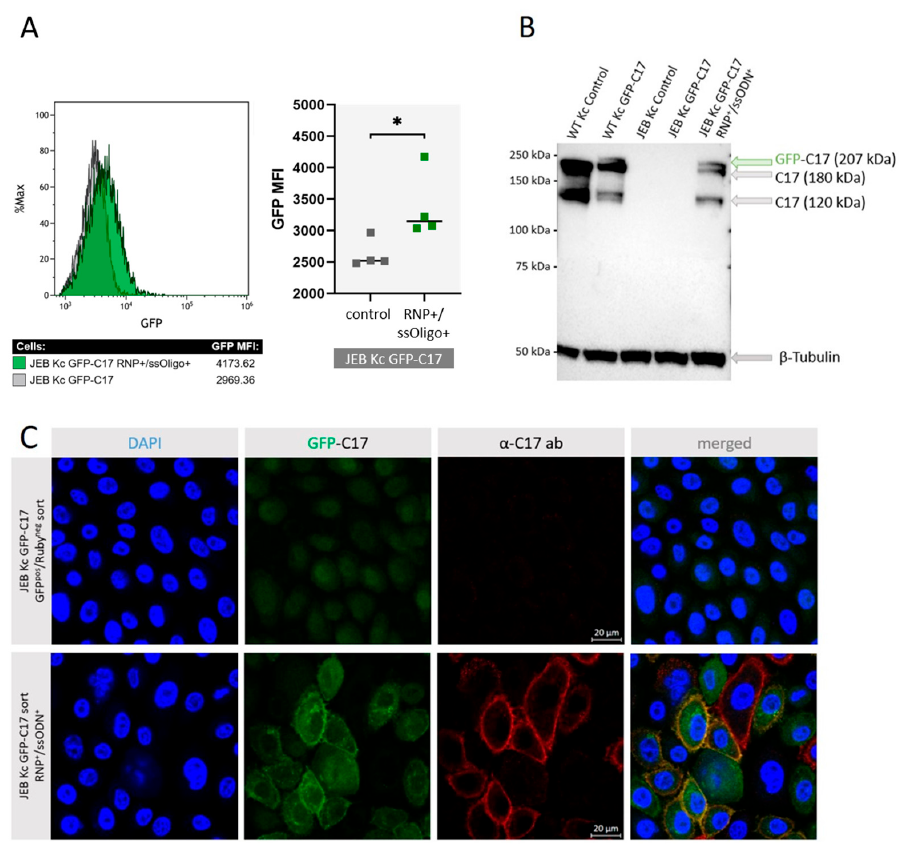
Figure 5. CRISPR/Cas9-mediated GFP-C17 restoration in JEB keratinocytes. ( A ) As a result of the RNP/ssODN-treatment of GFP-C17 mut -expressing JEB cells flow cytometric analysis showed a significant (*) increase of the median GFP signal intensity in treated cells upon gene repair in four individual experiments. Statistical analyses (paired Student’s t-test) were performed using GraphPad Prism 9. ( B ) Western blot analysis of cell lysates from RNP/ssODN-treated GFP-C17 mut -expressing JEB cells showed restored full-length C17 (180 kDa), full-length GFP-C17 (~207 kDa) as well as the presence of the C17 ectodomain at 120 kDa. ( C ) Immunofluorescence microscopy showed no fluorescence in untreated JEB GFP-C17 mut -expressing JEB cells, whereas RNP/ssODN treatment led to the accurate restoration and integration of full-length GFP-C17 within the plasma membrane of edited cells. The cell’s nuclei were stained with 4’, 6-Diamidino-2-phenylindol (DAPI, blue). 2.4. GFP-C17 Protein Is Deposited at the Correct Location within Organotypic 3D Cultures To further verify the correct localization of restored GFP-C17, immortalized WT fibroblasts and either WT Kc, untreated or RNP/ssODN-treated GFP-C17 mut -expressing JEB Kc were used to generate full-thickness skin equivalents (SE). Haematoxylin and Eosin (H&E) staining confirmed the correct formation of the skin layers revealing a normal epidermal stratification (Figure 6A). In SEs derived from untreated GFP-C17 mut - expressing JEB cells blister formation within the BMZ was observed. Using a C17-specific antibody, staining of cryosections from SEs expanded from RNP/ssODN-treated GFP- C17 mut -expressing JEB cells revealed a clear GFP-C17 restoration similar to the C17 expression in SEs derived from WT Kc (Figure 6B). A homogenous GFP signal was detected along the BMZ, confirming the accurate deposition of GFP-C17 between the dermal and the epidermal layer. Furthermore, the GFP signal colocalized with the detection of C17 via antibody staining. Additionally, colocalization of restored GFP-C17 with its key binding partner laminin-332 in human skin was evident (Figure S3).